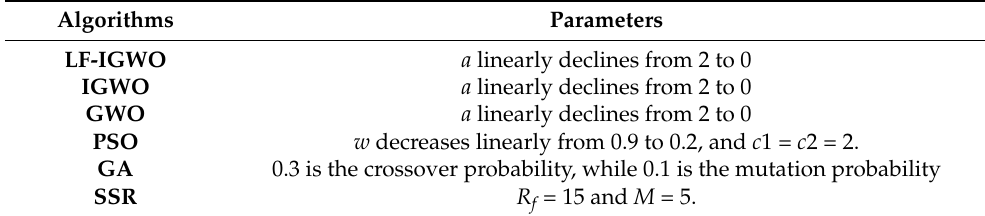
Table 5. Selection of parameters for different algorithms [35,41].